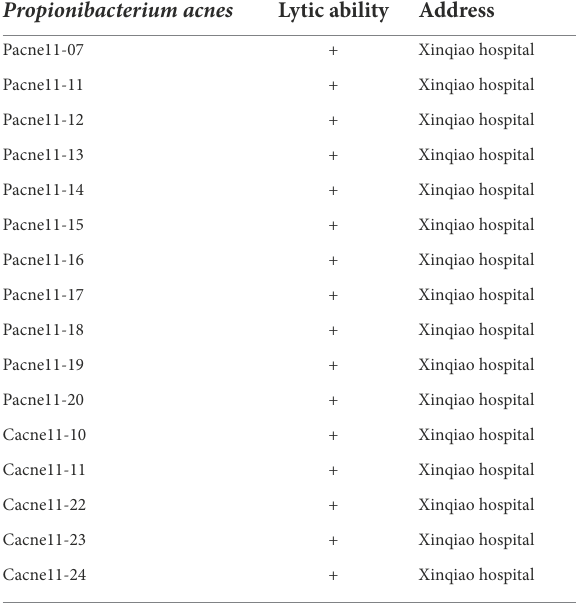
TABLE 3 The host range of φ